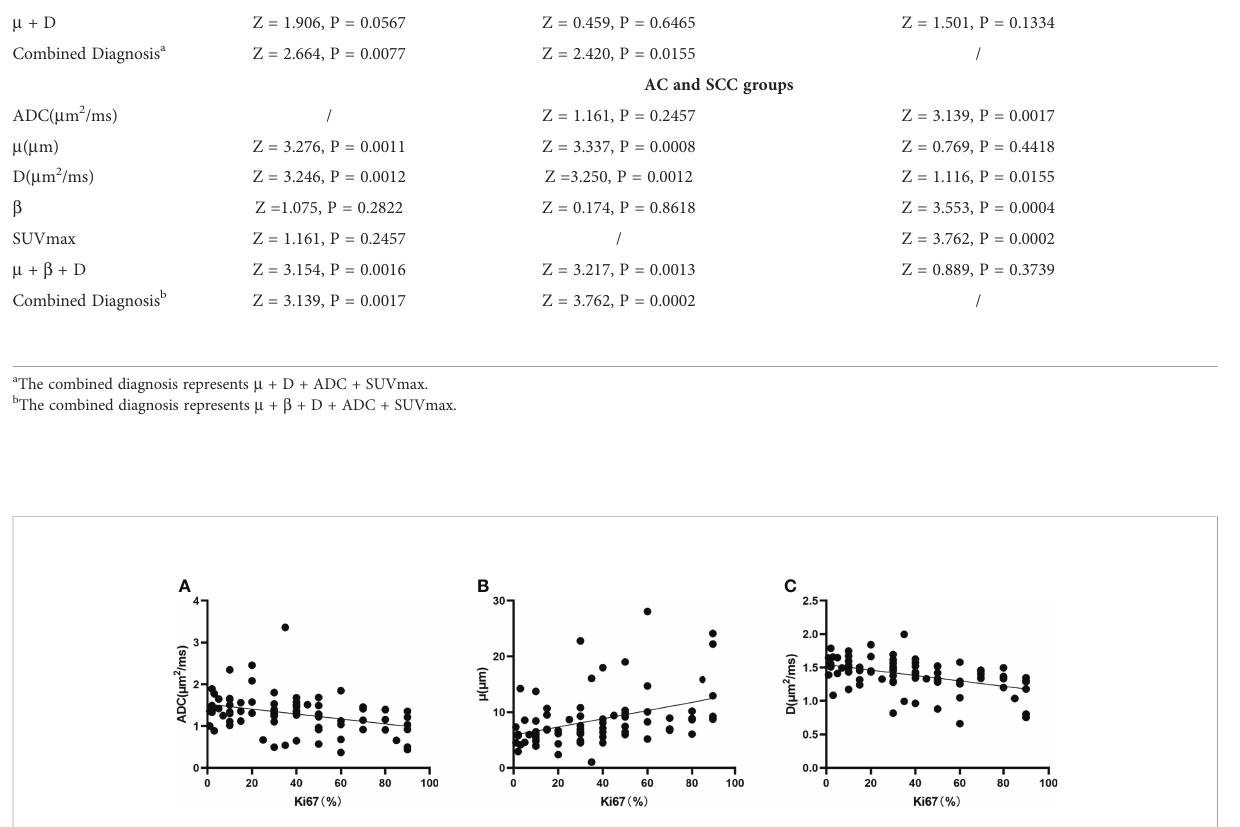
FIGURE 6 Correlation between (A) Ki67 and ADC (r = -0.346, P = 0.002), (B) Ki67 and m (r = 0.402, P < 0.001), and (C) Ki67 and D (r = -0.450, P < 0.001). D, diffusion coef fi